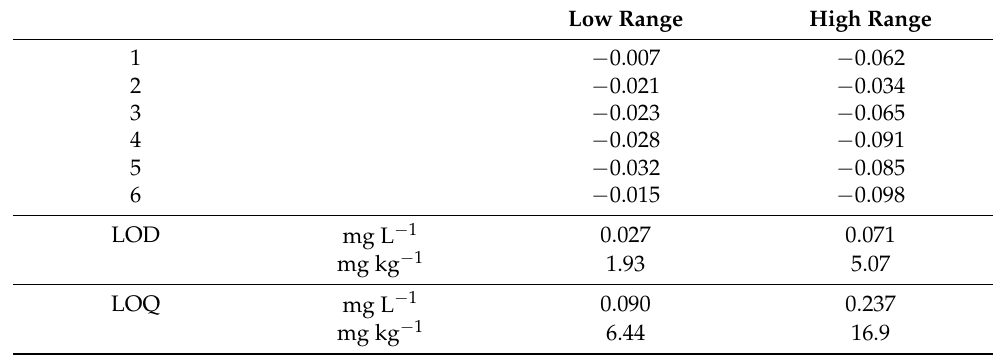
Table 1. Blank measurements used for the estimation of limits of detection (LOD) and quantification (LOQ).